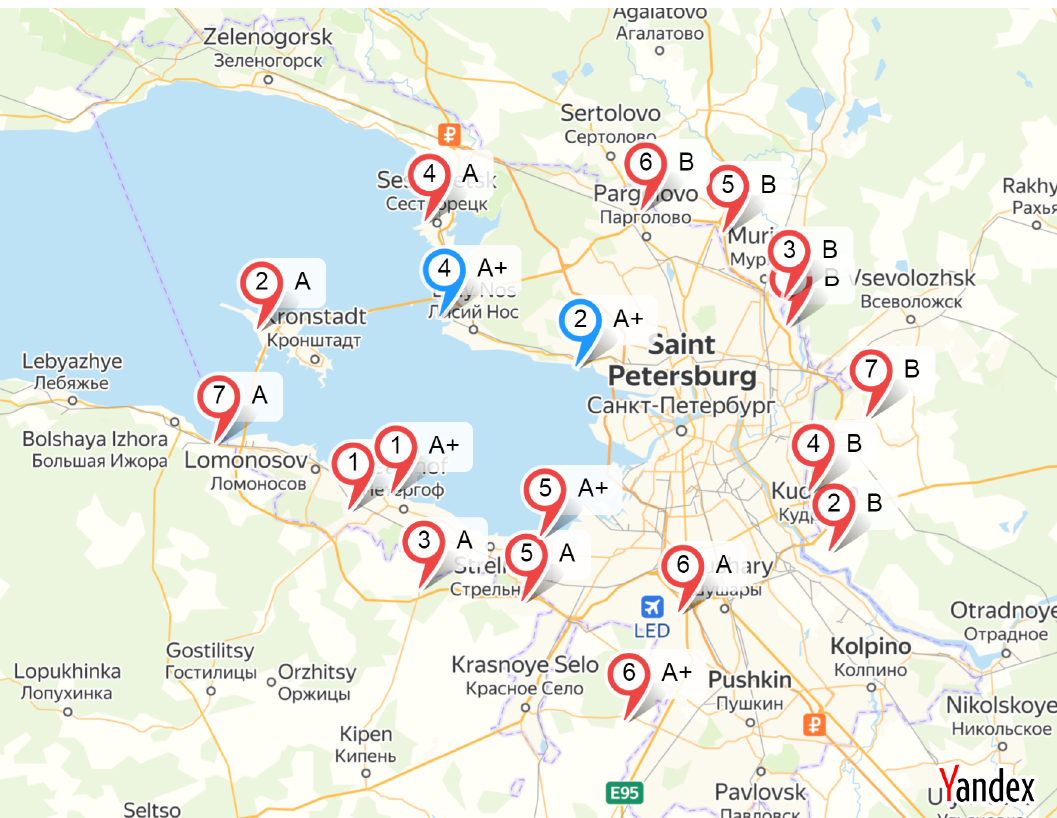
Figure 2. The set of FTS locations around the St. Petersburg agglomeration. Locations are marked by letters “A” and “B” with numbers. The “plus” sign near a location mark denotes that there is a possibility to use a local power supply at this location. The red colour denotes primary locations, and the blue colour denotes secondary locations. Map data © 2019